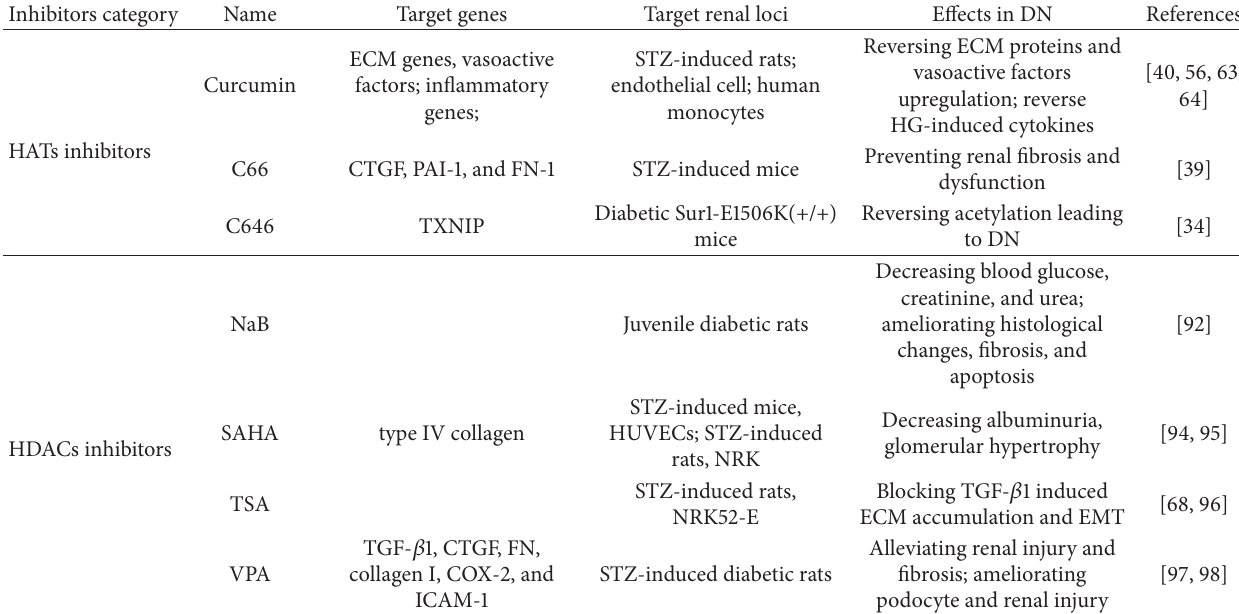
Table 3: Effect of inhibitors of HATs/HDACs in